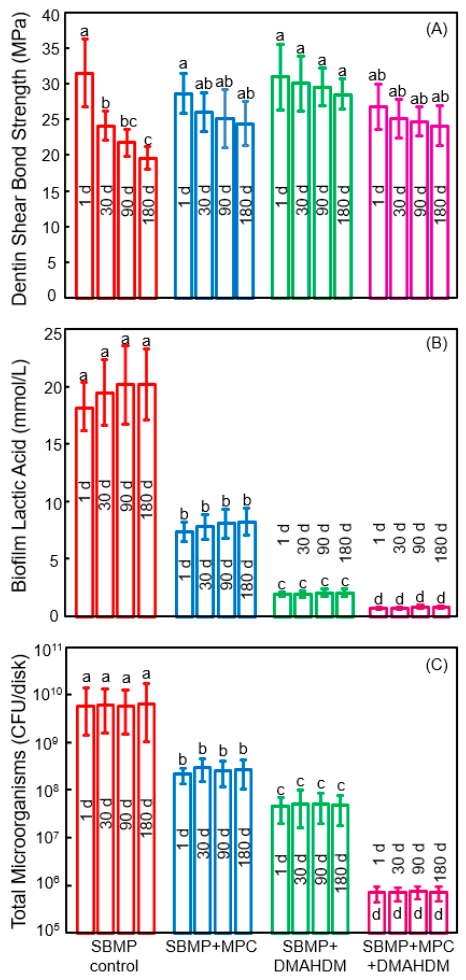
Figure 8. Effects of 6 months of water-aging on long-term durability. ( A ) Dentin bond strength. The bond strength of SBMP decreased during 180 days ( p < 0.05). There was no significant strength loss for those with MPC and DMAHDM ( p > 0.1); ( B ) Biofilm lactic acid (mean ± SD; n = 6); ( C ) Colony-forming units (cfu) for total microorganisms (mean ± SD; n = 6). cfu on SBMP+MPC+DMAHDM was nearly 4 logs less than that of SBMP control ( p < 0.05). For each group, there was no significant difference in cfu before and after 6 months of water-aging ( p > 0.1). In each plot, values with dissimilar letters are significantly different ( p < 0.05). (Reproduced with permission from [108]. Spinger Nature,